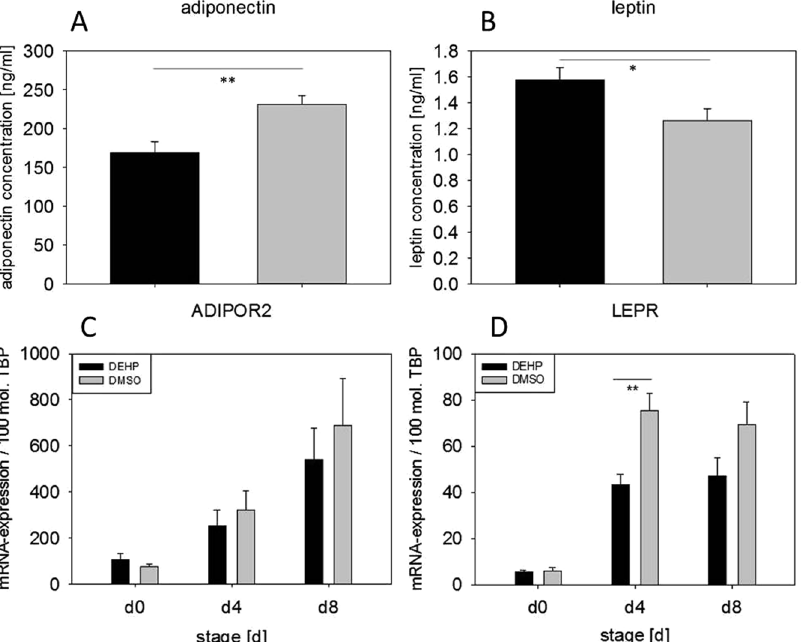
Figure 4. Adiponectin and leptin and their receptors after DEHP-exposure: SGBS cells were exposed to DEHP from d0-d4 and subsequently differentiated into adipocytes. For the adiponectin ( A ) and leptin ELISA ( B ) the cells were analyzed at d8. Statistics: Student’s t-test (Wilcoxon rank-sum test); N = 6, n = 1 (4 pooled wells each). For the analysis of mRNA expression of ADIPOR2 ( C ) and LEPR ( D ) samples were taken at d0, d4 and d8 of differentiation. The housekeeping gene for standardsation was the TATA-box binding protein (TBP). The caption “mRNA expression/mol. TBP” means expression of target gene per molecule(s) TBP. Statistics: Student’s t-test (Wilcoxon rank-sum test); N = 8, n = 1 (4 pooled wells